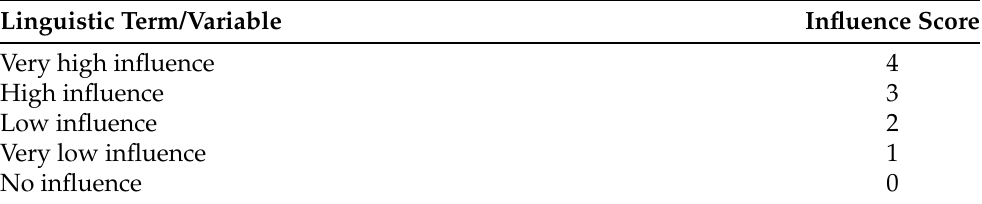
Table 3. Influence scores for expert judgments (see